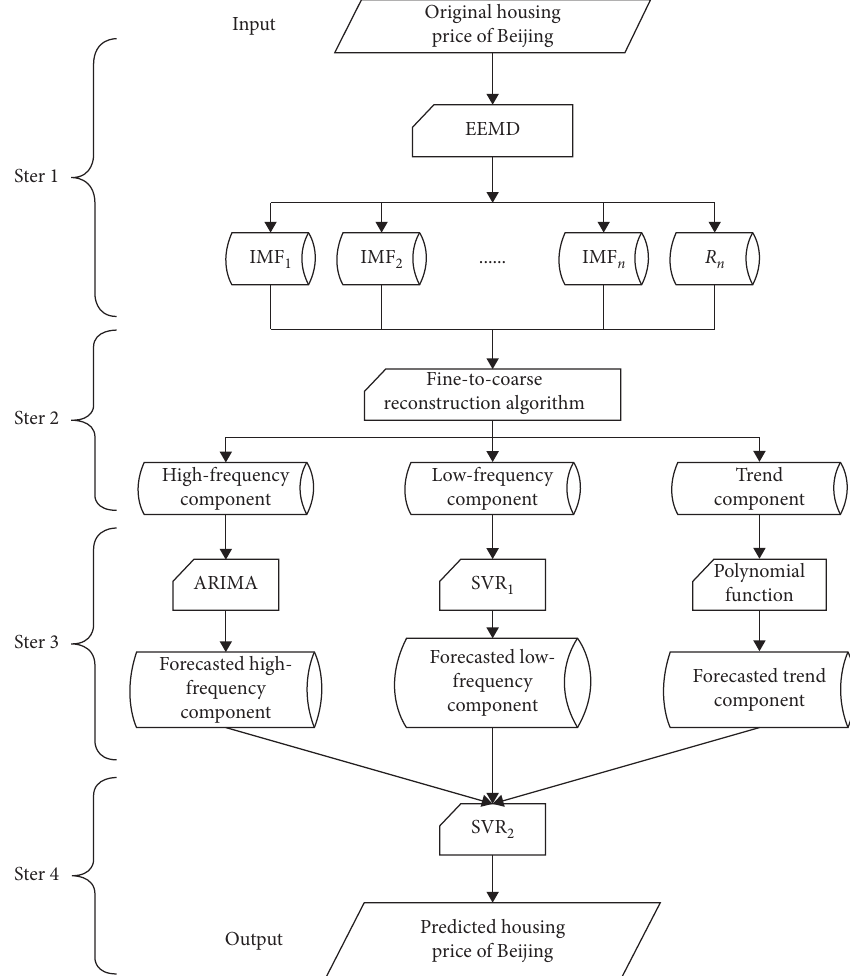
Figure 1: The proposed EEMD-based hybrid approach.